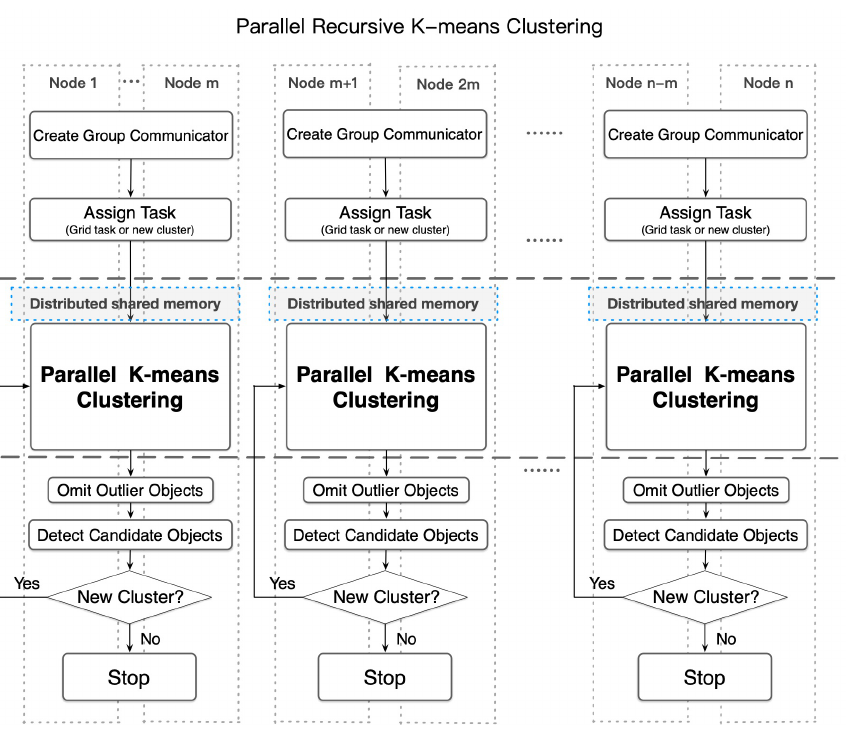
Figure 7. Optimized recursive k -means clustering implemented in